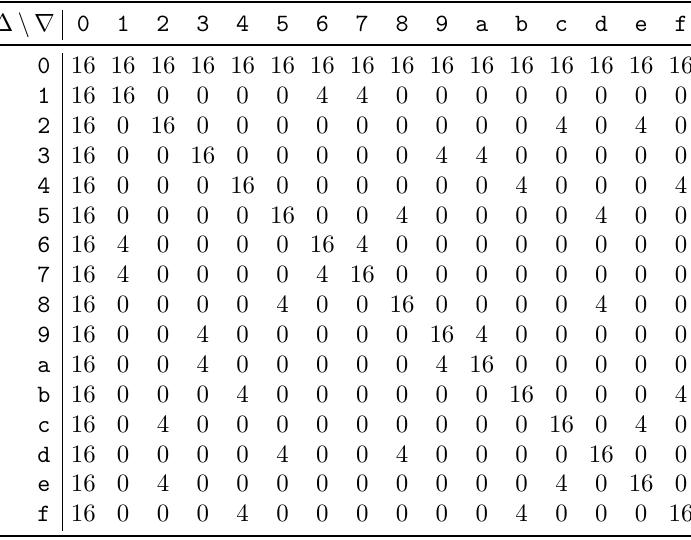
Table 9: Differential and boomerang properties of S-boxes in our applications. Cipher Size (bits) Diff. uniformity Boom. uniformity F-Boom.